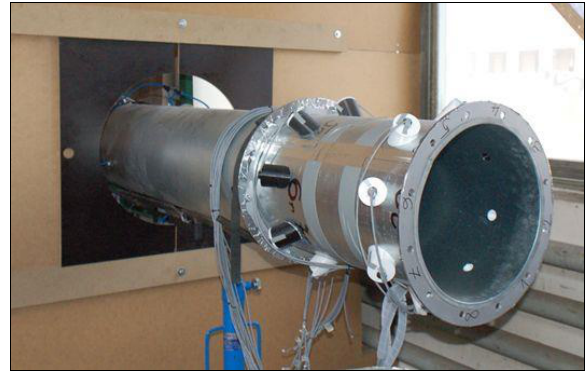
Fig. 1. Test prototype of ultrasonic flowmeter placed in 4Jtech laboratory, connected to an aerodynamic line.